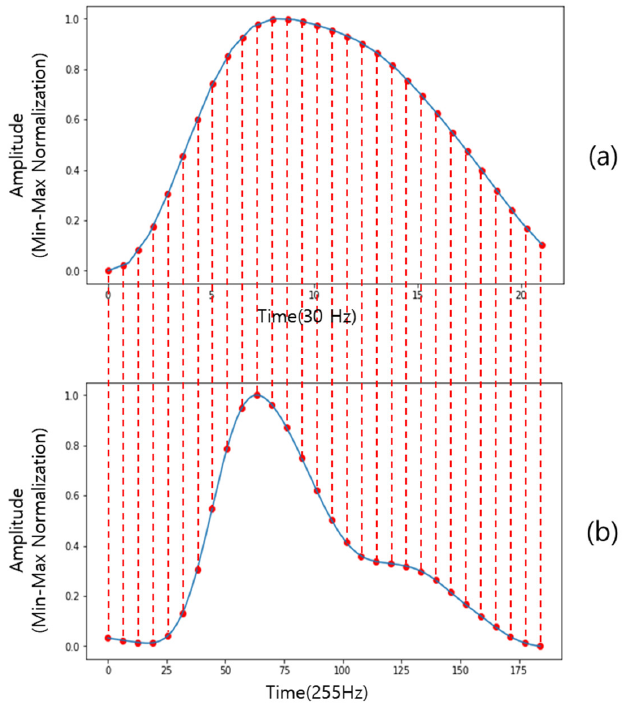
Figure 5. Correspondence of single cycle signal pairs: ( a ) rPPG; ( b ) cPPG.